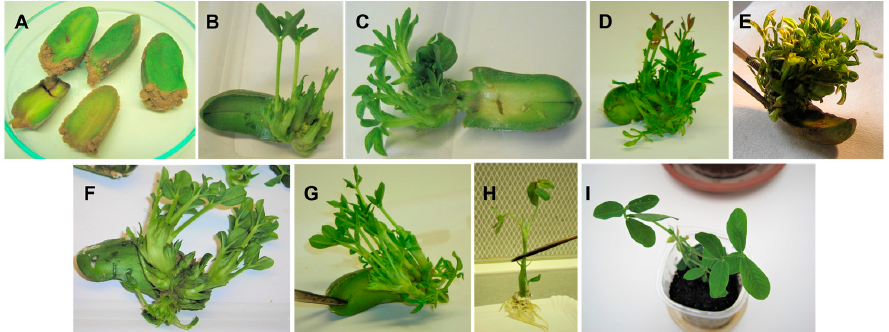
Figure 3. De novo regeneration of Arachis hypagaea L. cv. Virginia through direct organogenesis. ( A ) Non-responsive de-embryonated cotyledons, giving rise or not to soft, brown callus tissue. ( B ) Shoot regeneration when de-embryonated cotyledons are cultured on semi-solid MS medium, supplemented with 110 µ M BA or ( C ) 10 µ M TDZ. ( D ) Shoot regeneration in TIS under 16 min/16 h medium immersion, in liquid MS medium supplemented with 110 µ M BA or ( E ) 10 µ M TDZ. ( F ) shoot regeneration in TIS under 16 min/24 h medium immersion, in liquid MS medium, supplemented with 110 µ M BA or ( G ) 10 µ M TDZ. ( H ) Rooting of the obtained shoots on semi-solid MS.0 and ( I ) acclimatized plantlets under greenhouse